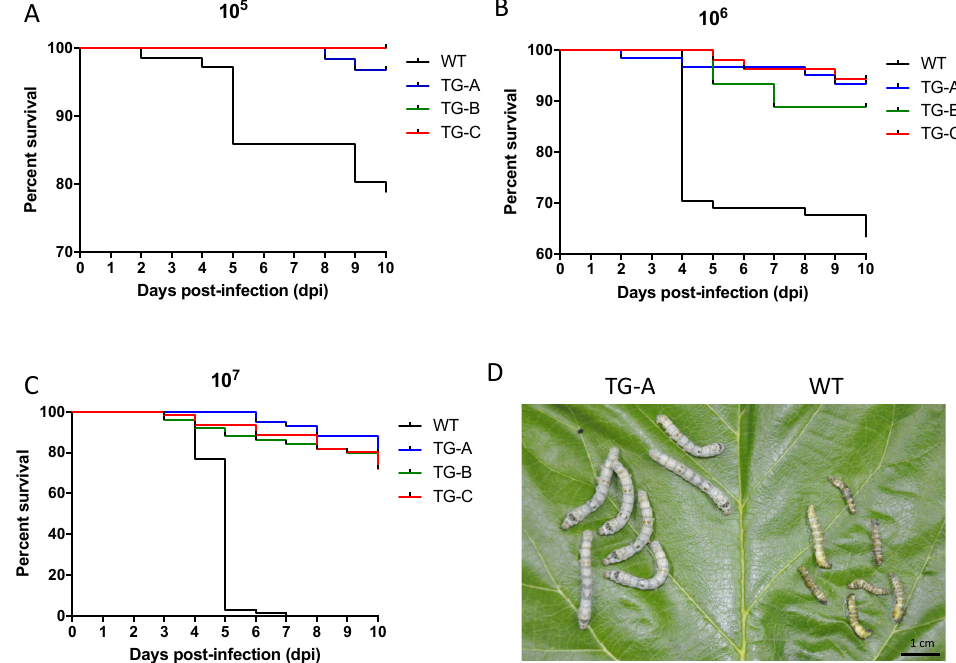
Figure 3. Transgenic silkworms had higher survival rates than wild type silkworms after infection with BmNPV. ( A – C ) Time course of survival rate of larvae after oral inoculation with 10 5 ( A ), 10 6 ( B ), and 10 7 ( C ) OBs/larva. Each group included 72 larvae. The mortality was scored at 10 dpi. ( D ) Photographs of representative TG-A and wild type silkworms at 60 hpi with 10 6 OBs/larva. 3.4. Targeted Mutations of BmNPV lef8 and lef9 in Infected Transgenic Silkworms To evaluate gene-editing efficiencies and to precisely analyze effects on lef8 and lef9 in BmNPV-infected silkworms, DNA samples were extracted from whole larvae of trans- genic and WT silkworms treated with 10 6 OBs/larva of BmNPV. Sanger sequencing and qPCR analyses were performed. The three transgenic lines have the same antiviral effi- ciency (Figure 3) and the CRISPR system cuts the virus genome randomly; therefore, we then took TG-A as an example for detecting the knockout efficiency of the target gene by the transgenic system. In TG-A larvae infected with BmNPV, PCR analysis indicated var- ious types of genome editing events presented in lef8 and lef9 (Figure 4A). qPCR analysis of RNA samples extracted from infected transgenic silkworm larvae and WT larvae at 48 hpi revealed that lef8 and lef9 mRNAs were expressed at negligible levels in the transgenic larvae, whereas levels of these mRNAs were higher in WT larvae (Figure 4C). No gene editing was found in the BmNPV DNA from WT, while there are many types of muta- tions, insertions, small and large deletions in the BmNPV DNA recovered from the trans- genic silkworms (Figure 4D). These results indicated that the transgenic CRISPR/Cas9 sys- tem effectively disrupted BmNPV lef8 and lef9 .